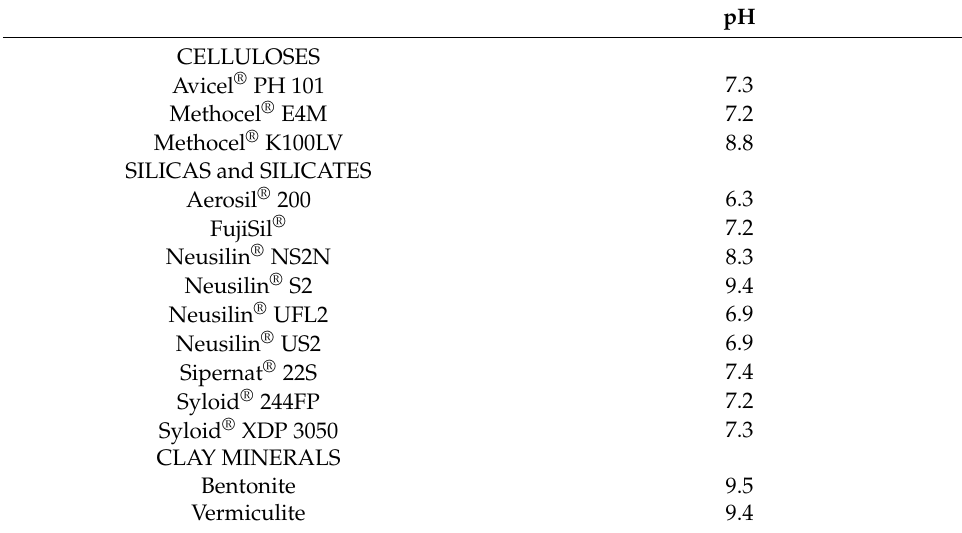
Table 5. pH leaching of powder